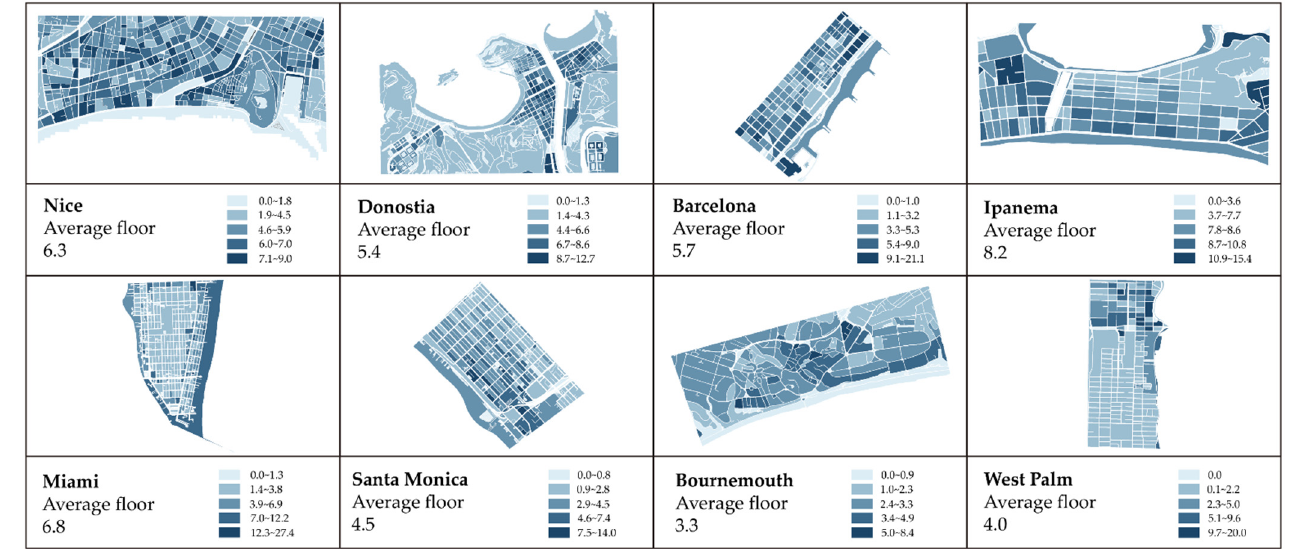
Figure 13. The distribution of average floors in successful coastal cases.